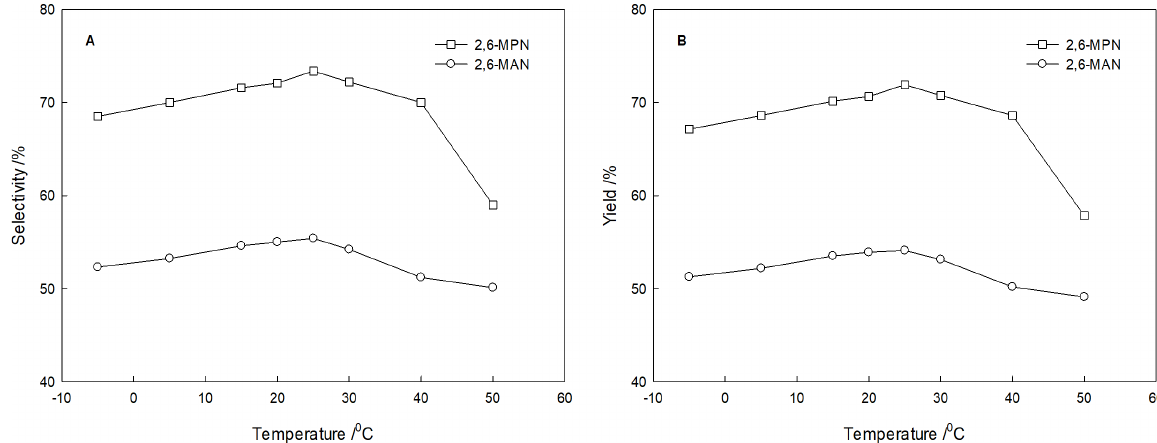
Figure 3: The relationship between the reaction temperature and the results of the acylation reaction of